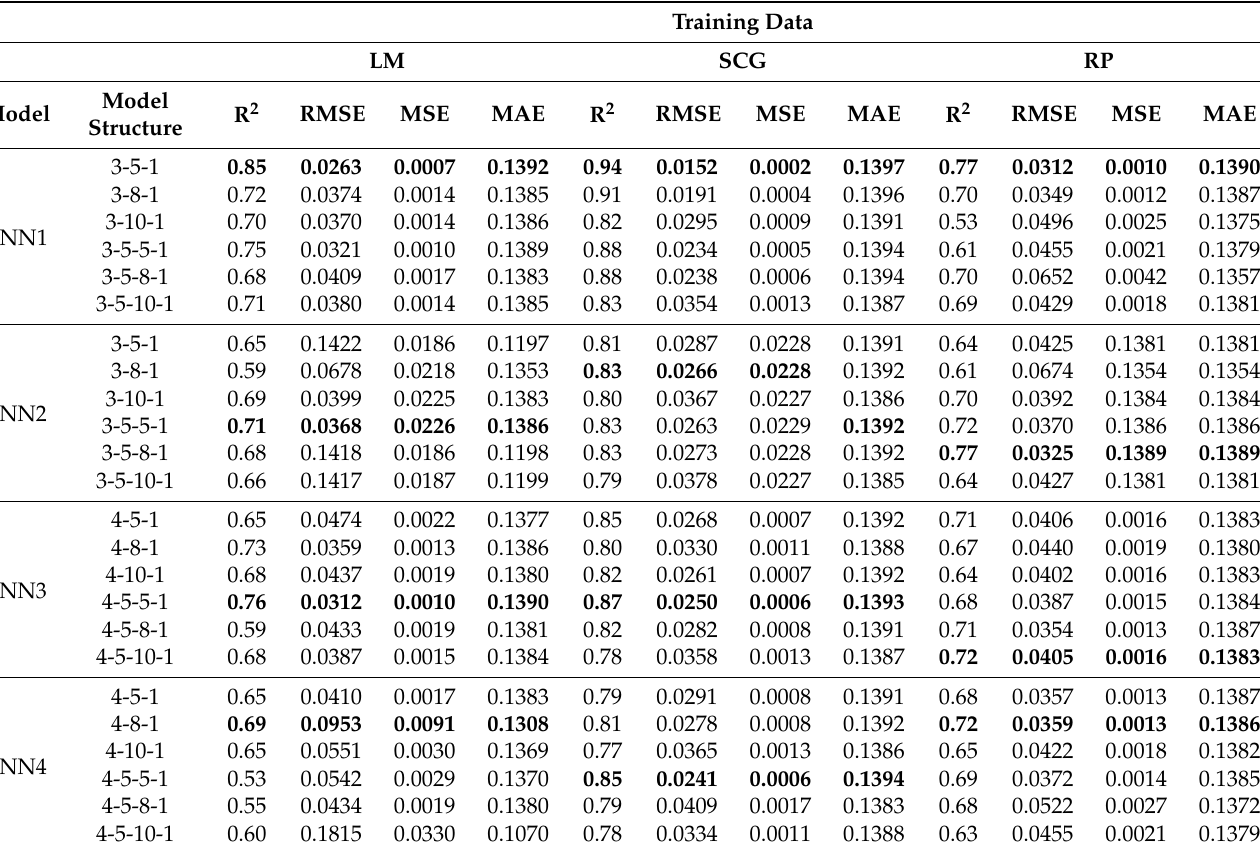
ANN: Artificial neural network, R 2 : Determination coefficient, RMSE: Root mean square error, MSE: Mean square error, MAE: Mean absolute error, LM: Levenberg–Marquardt, SCG: Scaled conjugate gradient, RP = Resilient backpropagation. (The bold font represents the best results in